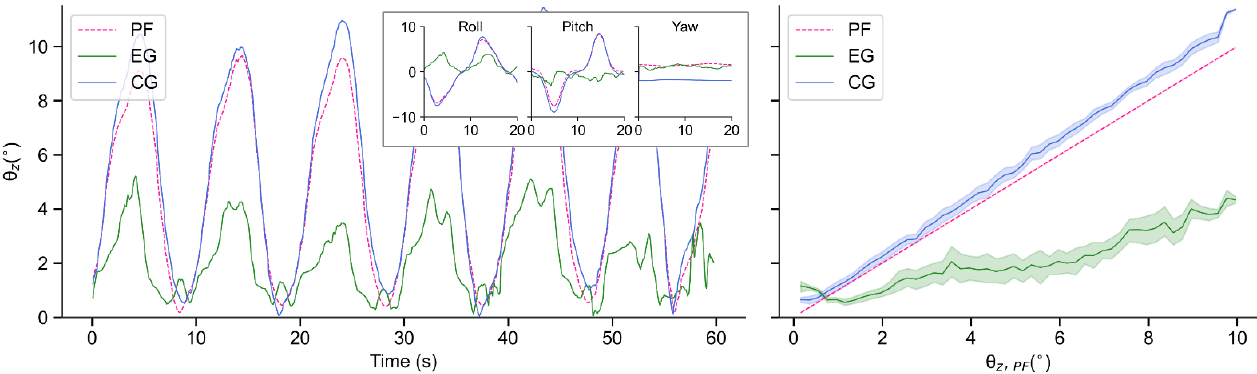
Figure 15. Tilt angles θ z of PF, EG and CG in real-world experiments when T = 20 s: Time-domain variations of tilt angles ( left ); Balance performance at varying tilt angles of PF ( right